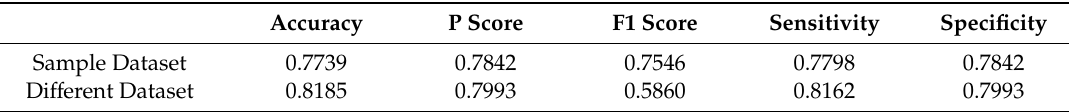
Table 3. Performance on sample and di ff erent